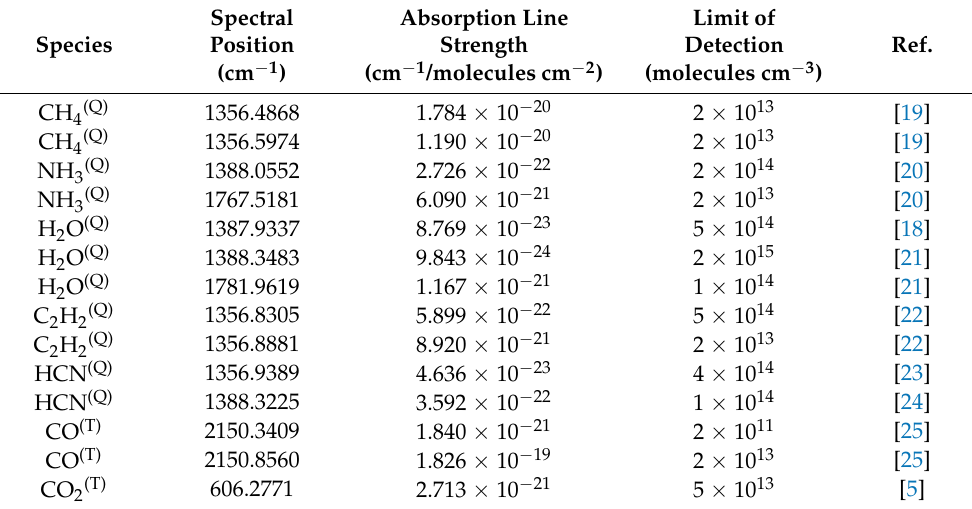
Table 1. Species, spectral positions, room temperature line strengths, used for IRLAS measurements and their estimated limits of detection. The laser source for the given spectral position is denoted with a Q for EC-QCL (external-cavity quantum cascade lasers) and a T for TDL (lead salt tunable diode laser) sources, respectively. Data taken from the HITRAN database